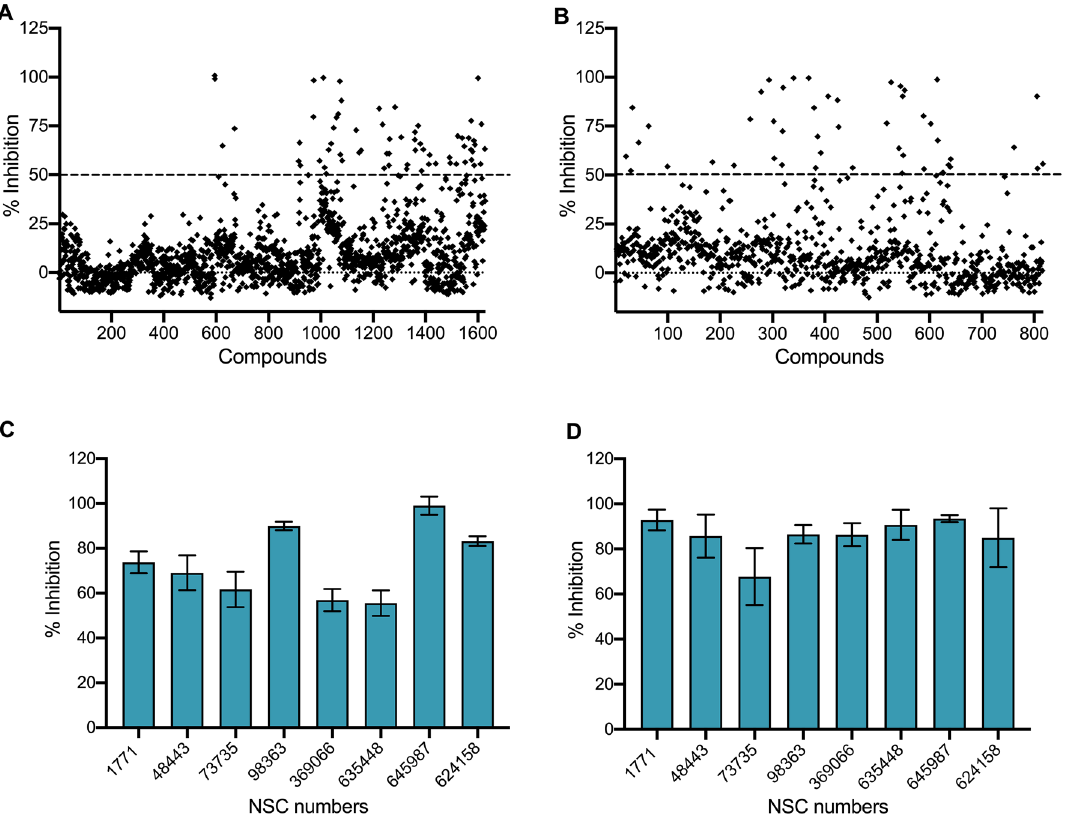
Figure 3. ( A , B ) Preliminary screening of HSAT activity using small molecules belonging to National Cancer Institute-Developmental Therapeutic Program Library. ( A ) The entire NCI-DTP library comprising of 2443 compounds belonging to either diversity set ( A ) and mechanistic set (B) was screened at 100 µM concentration to identify inhibitors for Rv3341. The data shown in this panel is percentage inhibition obtained from a single experiment. ( C , D ) HSAT enzymatic inhibition by the identified primary hits. The homoserine acetyl transferase activity associated with HSAT homologs from either M. tuberculosis ( C ) or S. aureus ( D ) was measured in the presence of identified primary hits at 100 µM concentration. The data shown in these panels is mean ± S.E. of percentage inhibition obtained from three independent experiments performed in